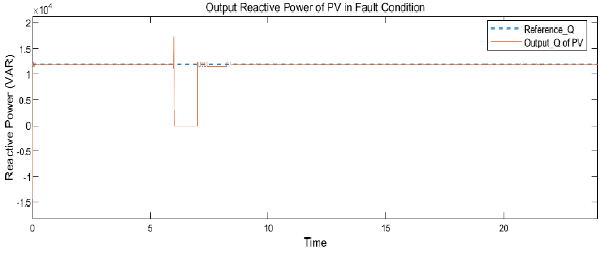
Fig.10. Real power output of PV in switching condition